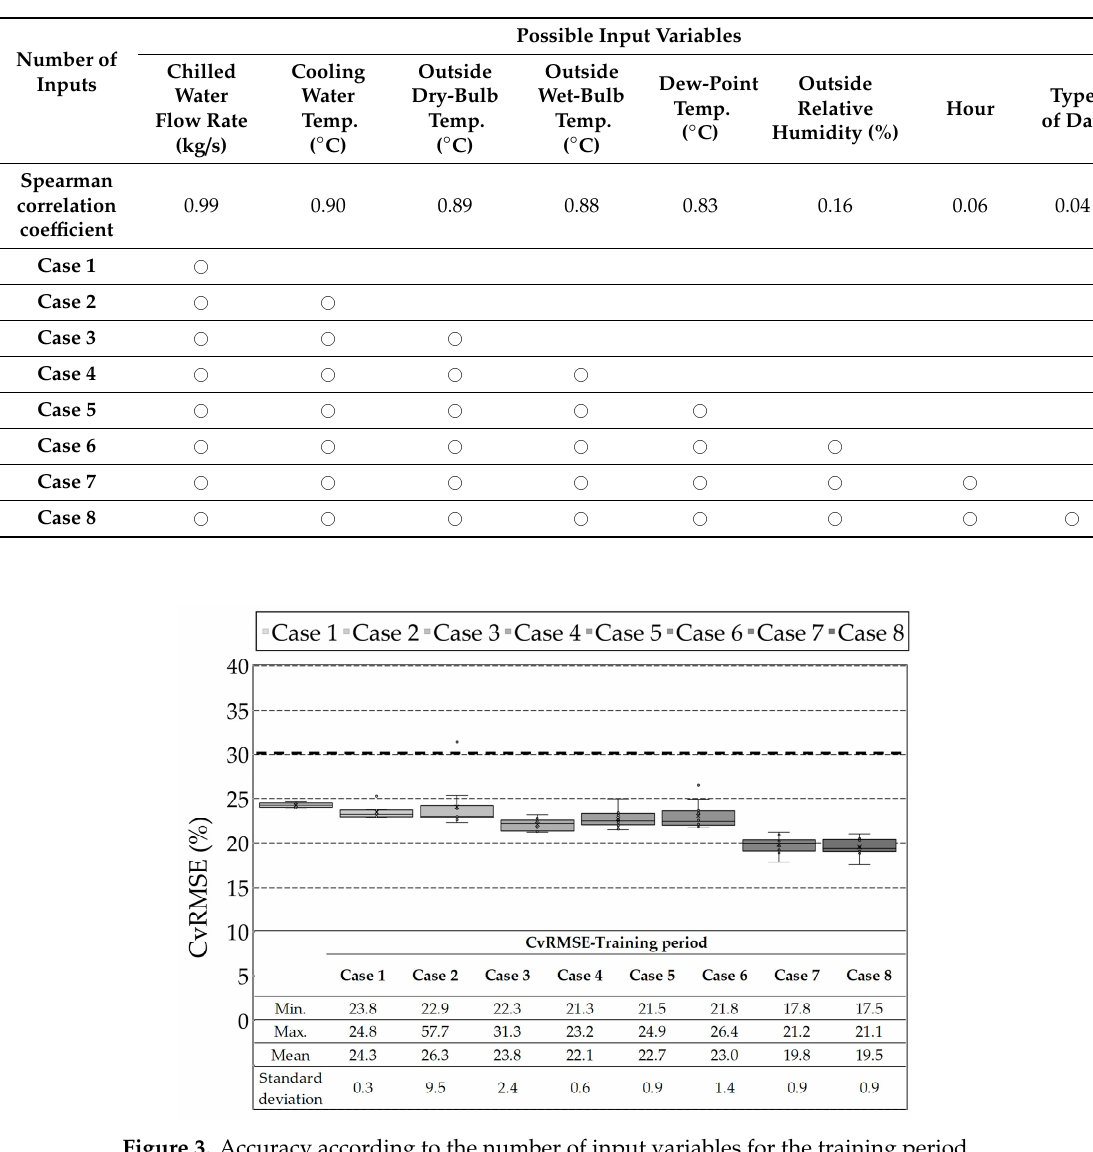
Table 6. Conditions for the input variables.